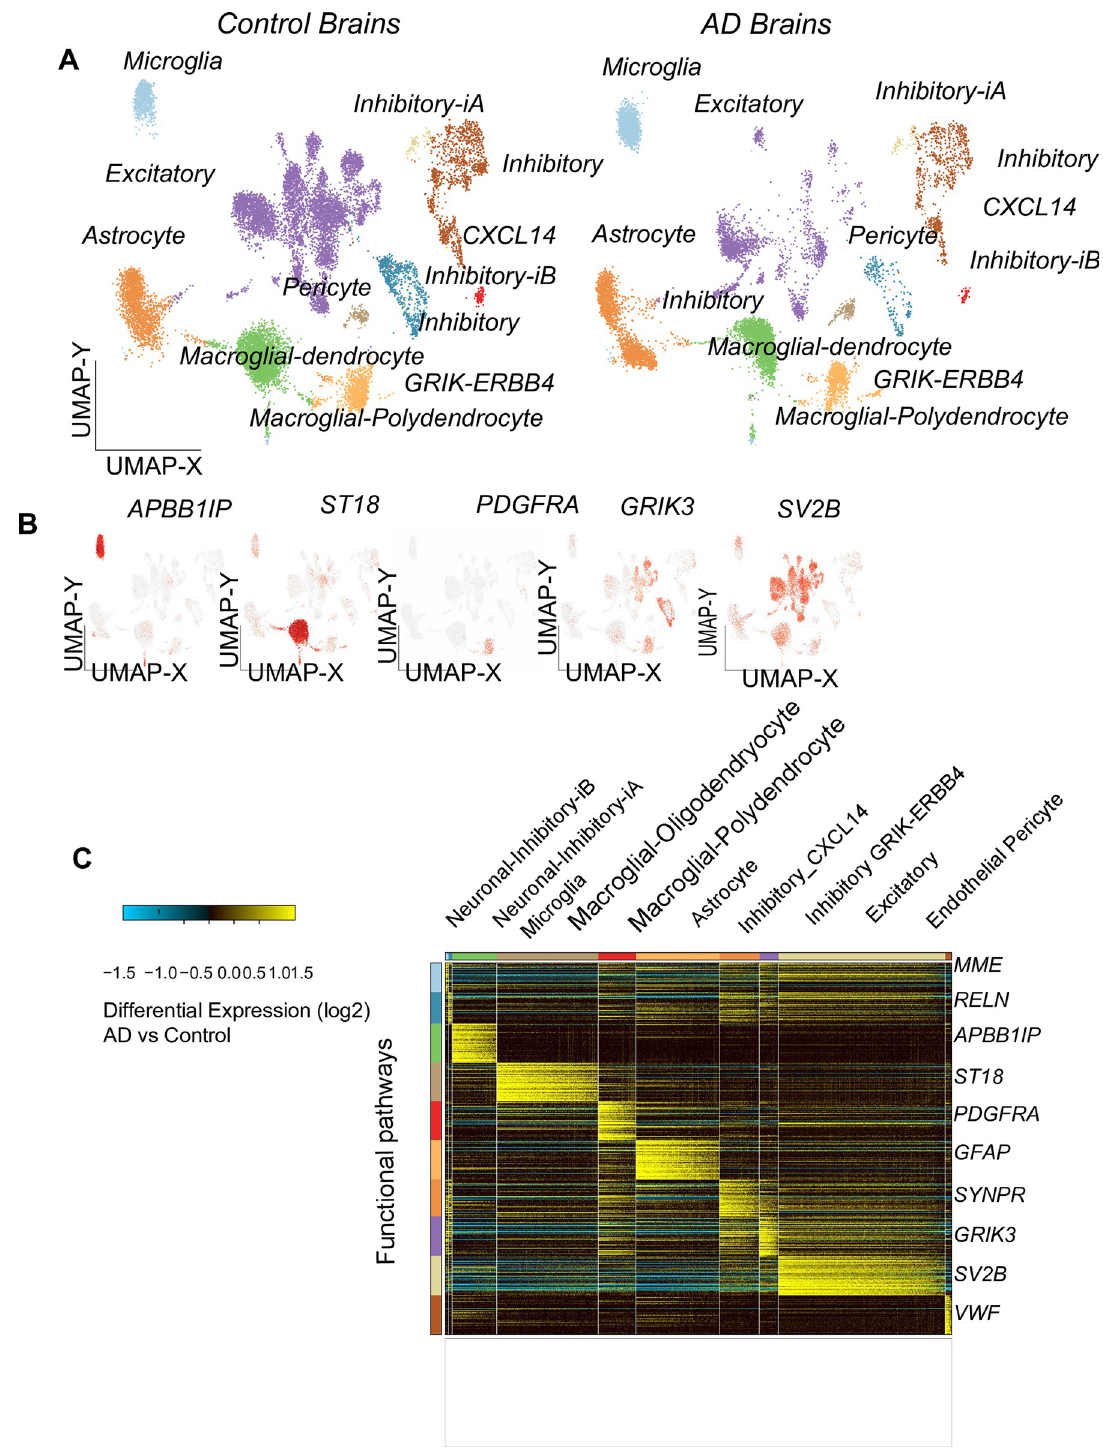
Fig 1. AltAnalyze analysis of the AD vs control samples. Results of AltAnalyze (www.altanlyze.org) Python software analysis on the Alzheimer’s vs. control RNA-Seq single cell dataset. A) plots of control brain samples (n = 2 each, x axis: UMAP-X, y axis: UMAP-Y. B) UMAP of AD samples highlighting microglia, astrocyte excitatory neurons gene marker clusters.